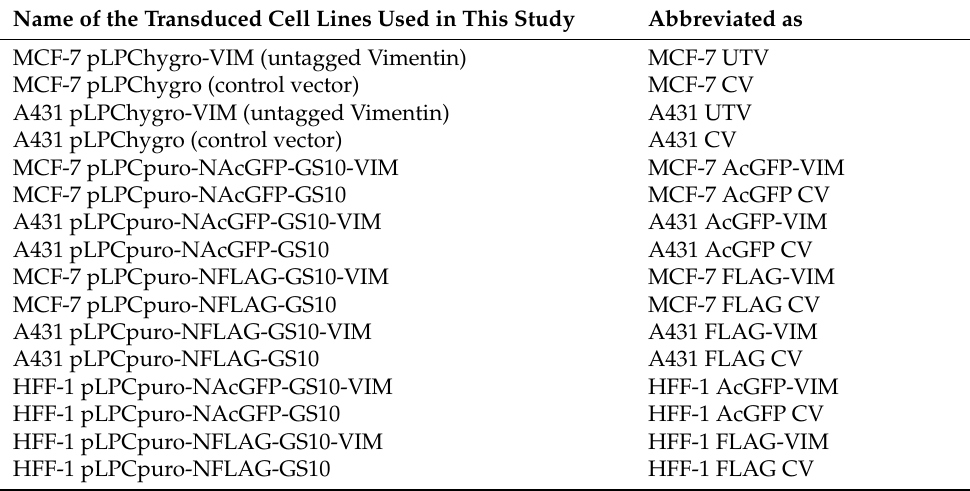
Table 3. List of stably transduced cell lines used in this study. Name of the Transduced Cell Lines Used in This Study Abbreviated as MCF-7 pLPChygro-VIM (untagged Vimentin) MCF-7